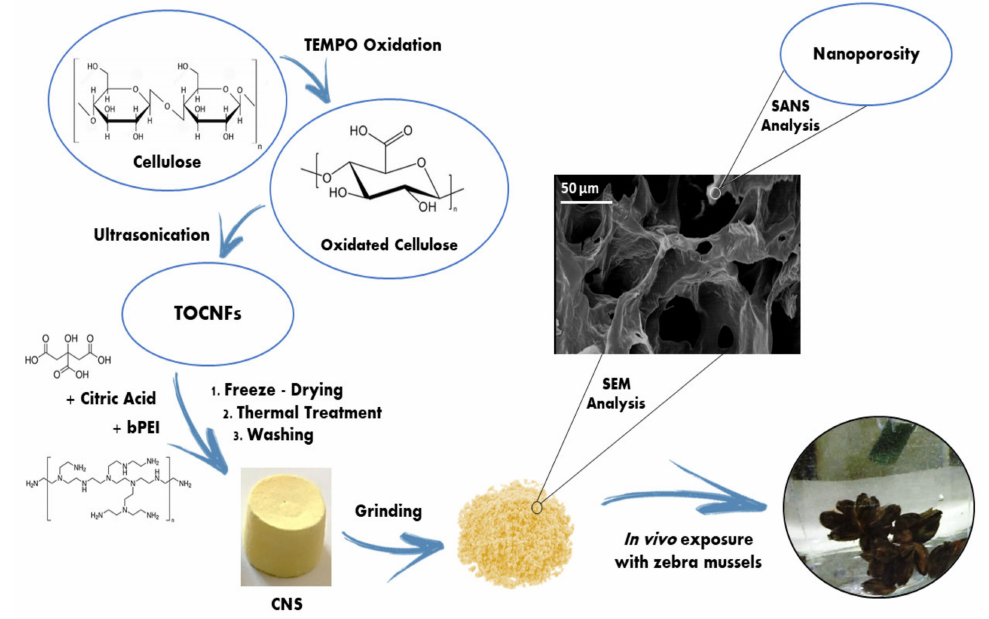
Figure 1. Schematic representation of synthetic and morphological aspects of cellulose-based nanosponge